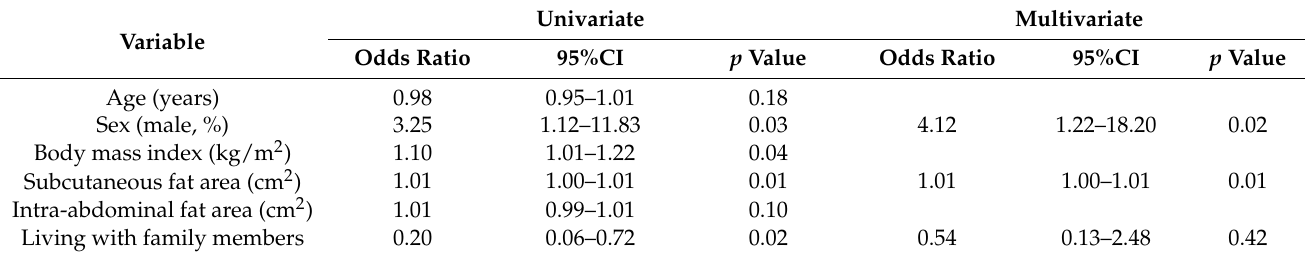
Abbreviations: CI, confidence